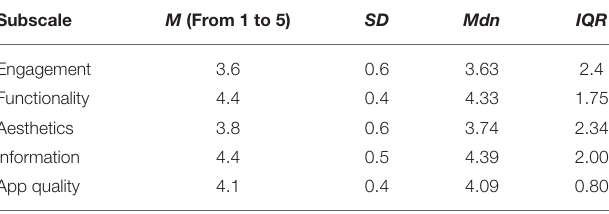
TABLE 1 | uMARS objective subscale scores for Psixport. Subscale